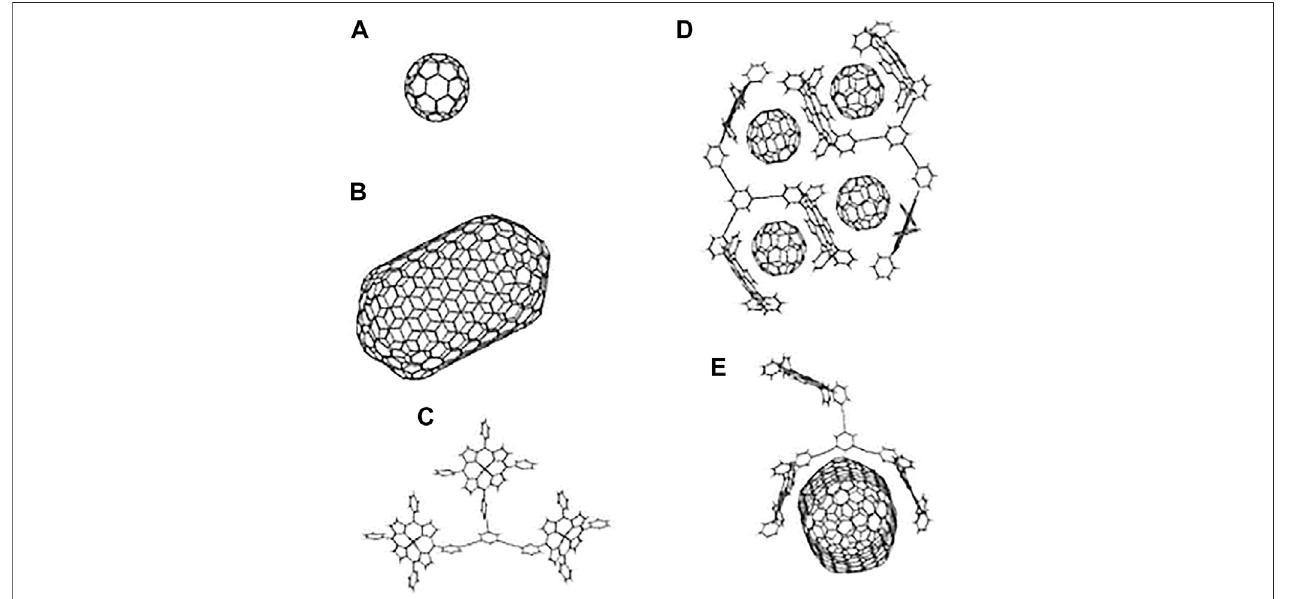
FIGURE12| DFT-leveloptimisedstructuresfor thehosts and guestsstudied: (A) C 60 molecule; (B) [10,10] capped SWNT; (C) simpli fi ed tripodal porphyrin host 1 (ZnP); (D) a 4 : 2 C 60 : porphyrin (ZnP) host complex; (E) porphyrin host (ZnP) [10,10] capped SWNT composite. Reproduced with permission from Pascu et al. (2008).